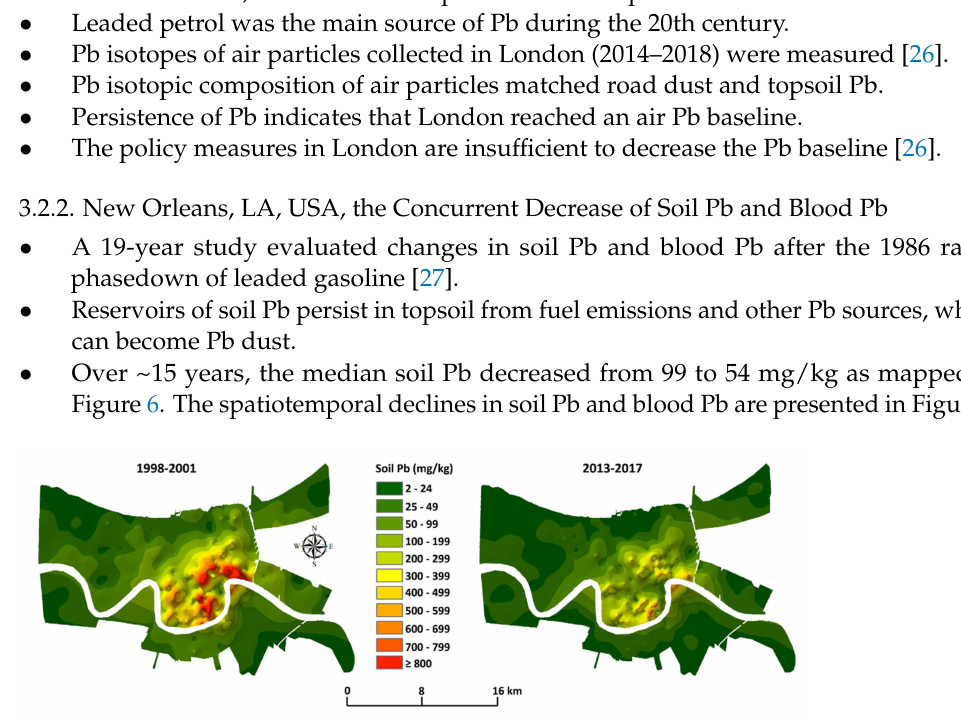
Figure 6. Spatiotemporal declines of soil Pb in New Orleans. The maps of New Orleans were created from a citywide survey of the metropolitan communities ( n ~5400 soil samples systematically collected across 274 census tracts)